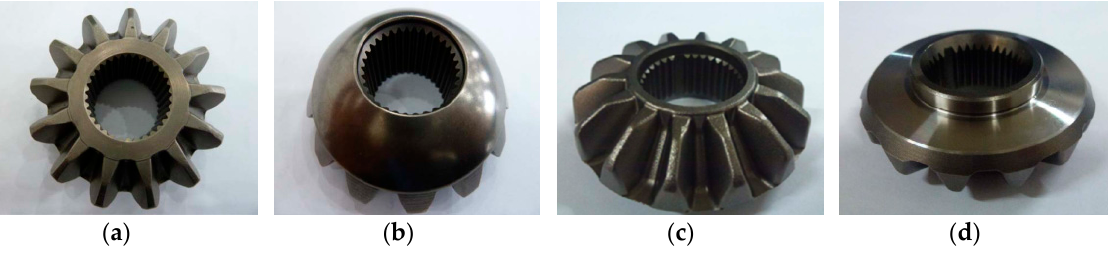
Figure 2. Samples of gear A 4 and F 6 : ( a ) Top surface of gear A 4 ; ( b ) Bottom surface of gear A 4 ; ( c ) Top surface of gear F 6 ; ( d ) Bottom surface of gear F 6 .